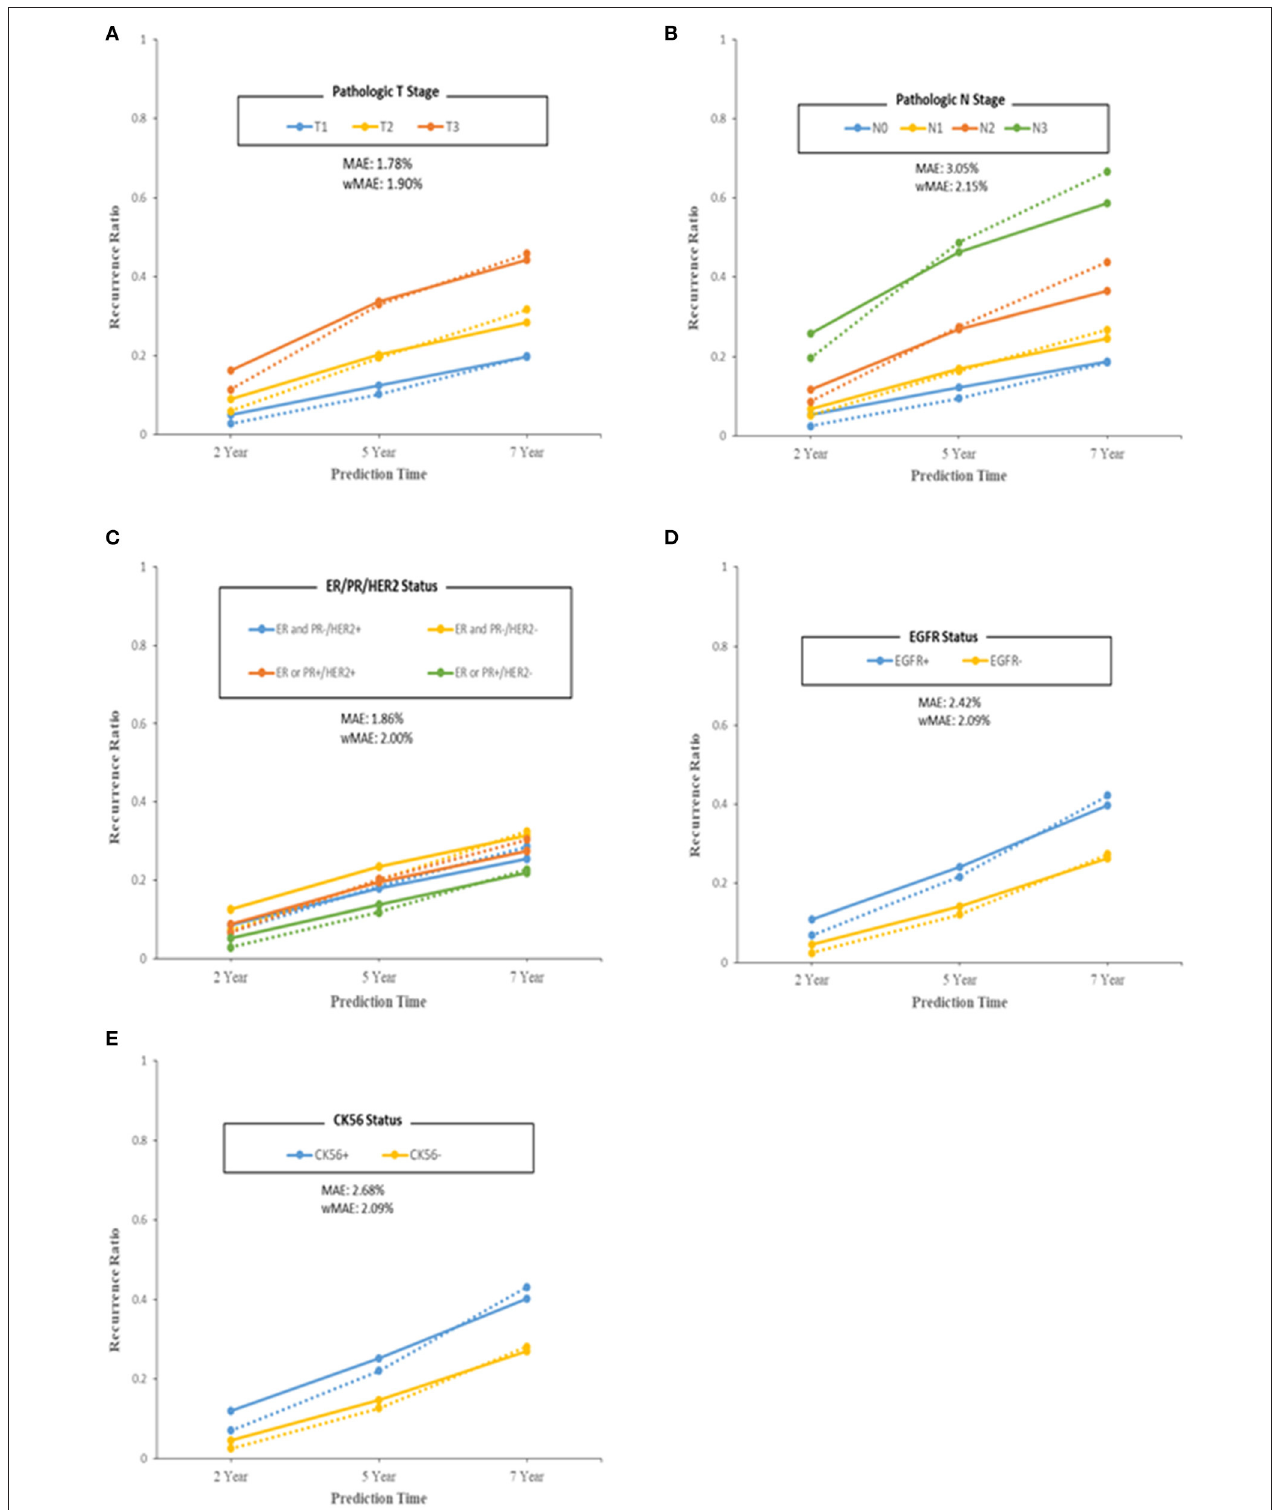
FIGURE 4 | Performance of the final model in terms of model error (predicted–observed) over each of the 2/5/7 years. Patients were grouped by breast cancer features. (A) Pathologic T stage. (B) Pathologic N stage. (C) ER/PR/HER2 status. (D) EGFR status. (E) CK56 status. For model specificity and accuracy, Median Absolute Error (MAE) and weighted Mean Absolute Error (wMAE) were calculated at each group or bin. Solid lines indicate observed recurrence proportion, and dashed lines indicate predicted recurrence proportion.